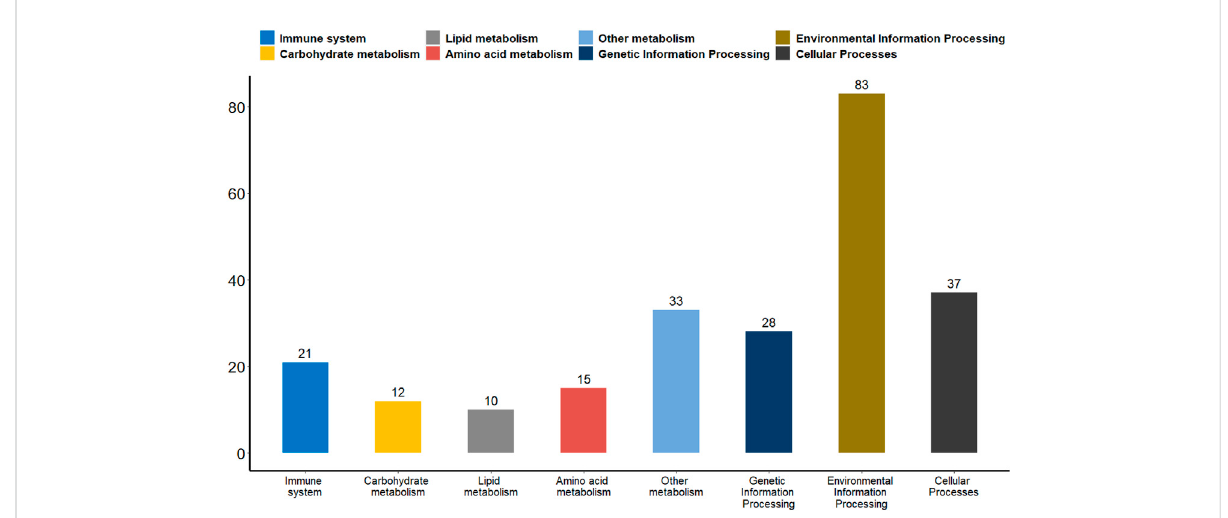
FIGURE 3 A bar plot of the functional annotation results of DMGs. The X-axis represents the biological process on the annotation. The Y -axis represents thenumberofDMGsfor abiologicalprocessontheannotation.Weextracted onlytheimmune system,carbohydratemetabolism, lipidmetabolism, amino acid metabolism, metabolism of other substances, genetic information processes, environmental information processes and cellular processes for our presentations.